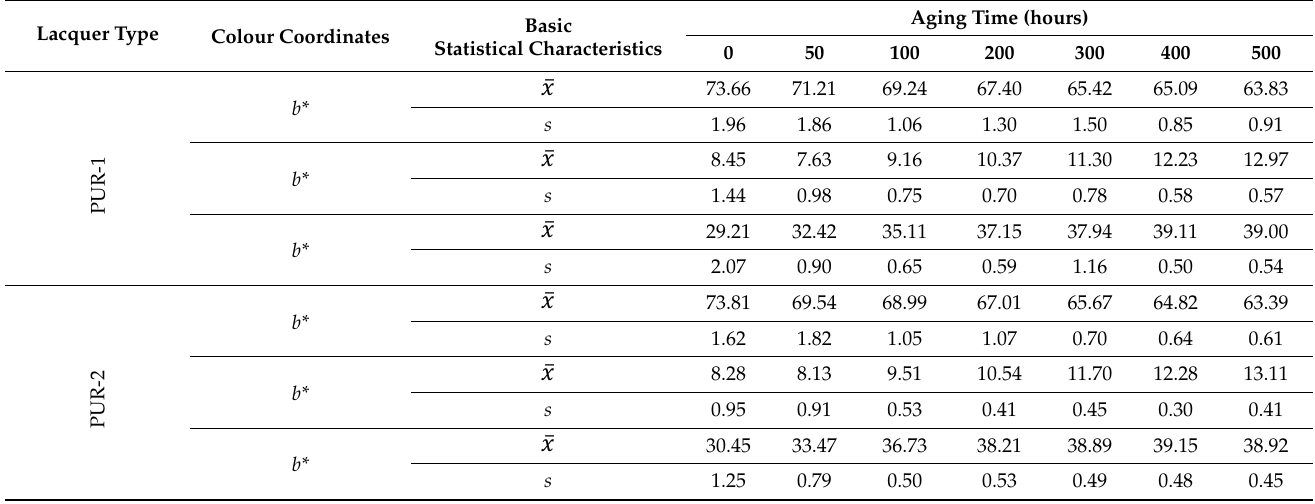
Table 3. Basic statistical characteristics of colour coordinates L * , a * , and b * corresponding to different phases of the accelerated aging process of spruce wood surface-treated with polyurethane lacquers. (The number of measurements for each set n = 50.)